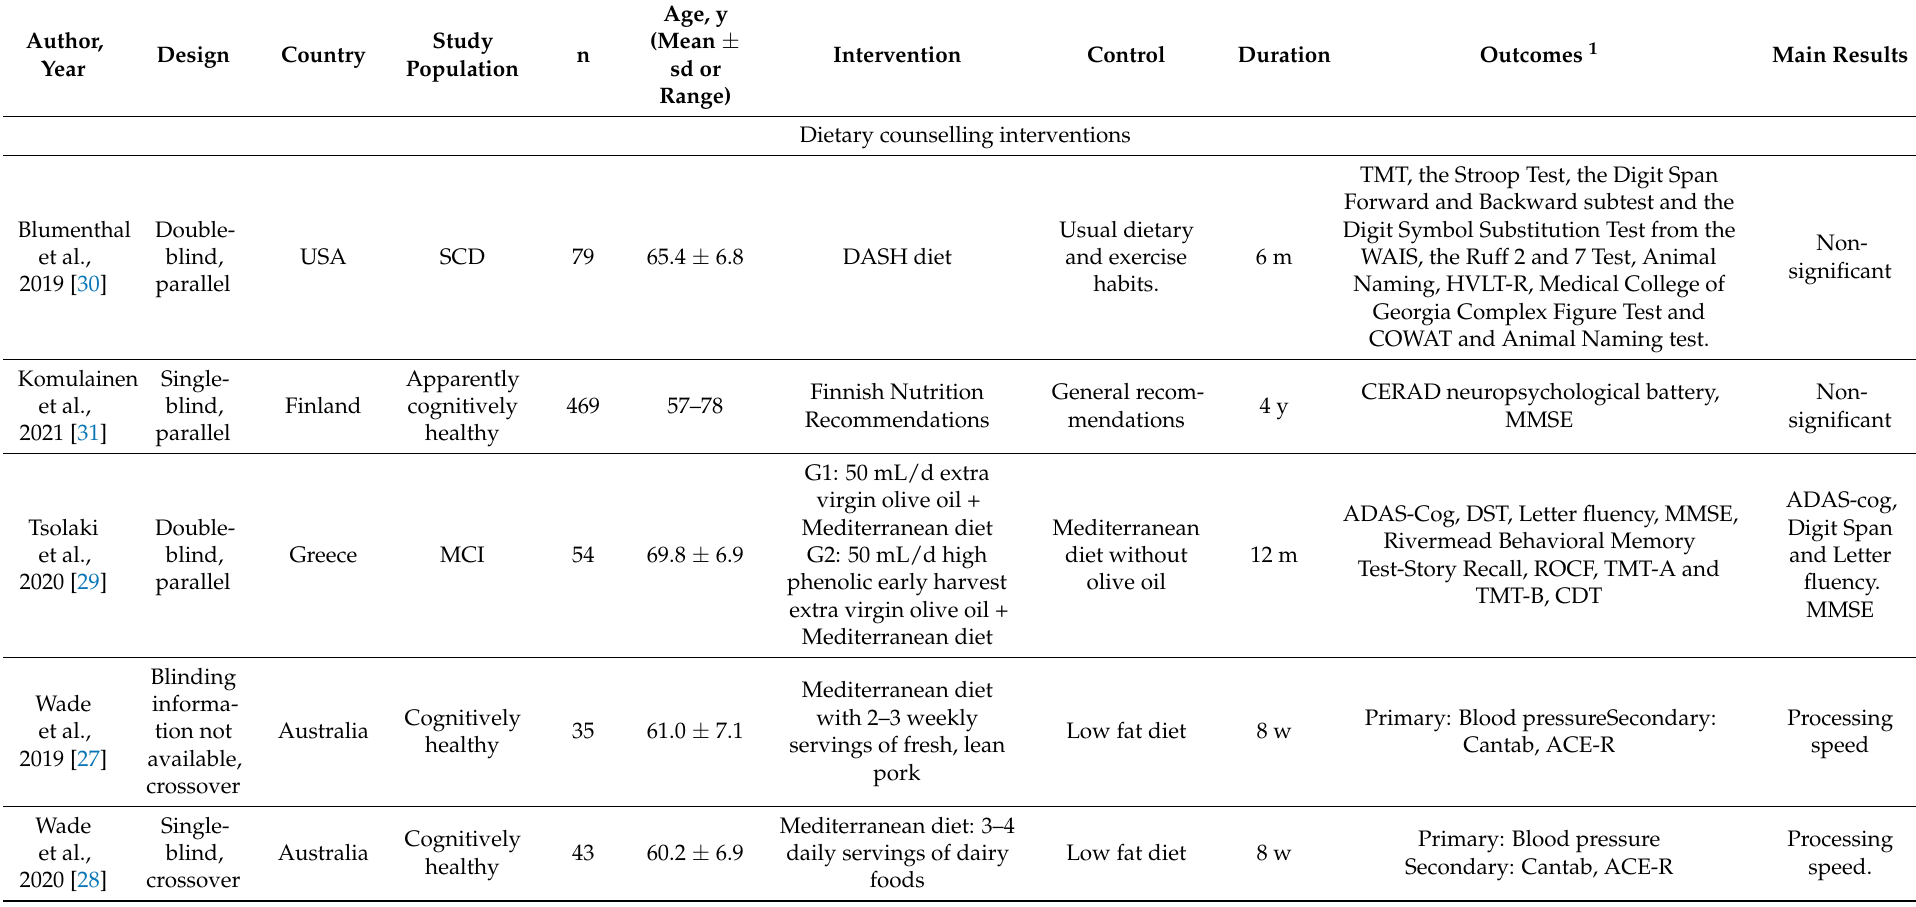
Table 1. Characteristics of the 61 studies included in the systematic